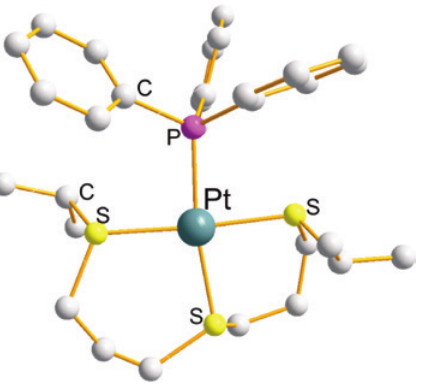
){ η 3 -S C H )] + (Loeb and Mansfield, 3 3 12 24